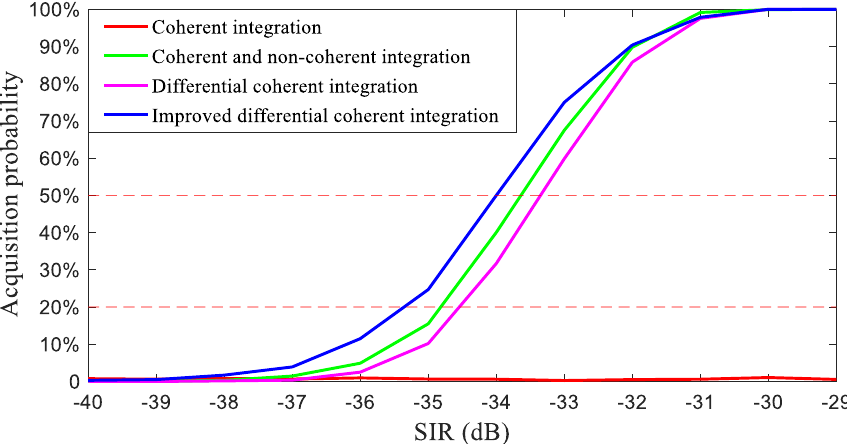
Figure 10. Acquisition probability